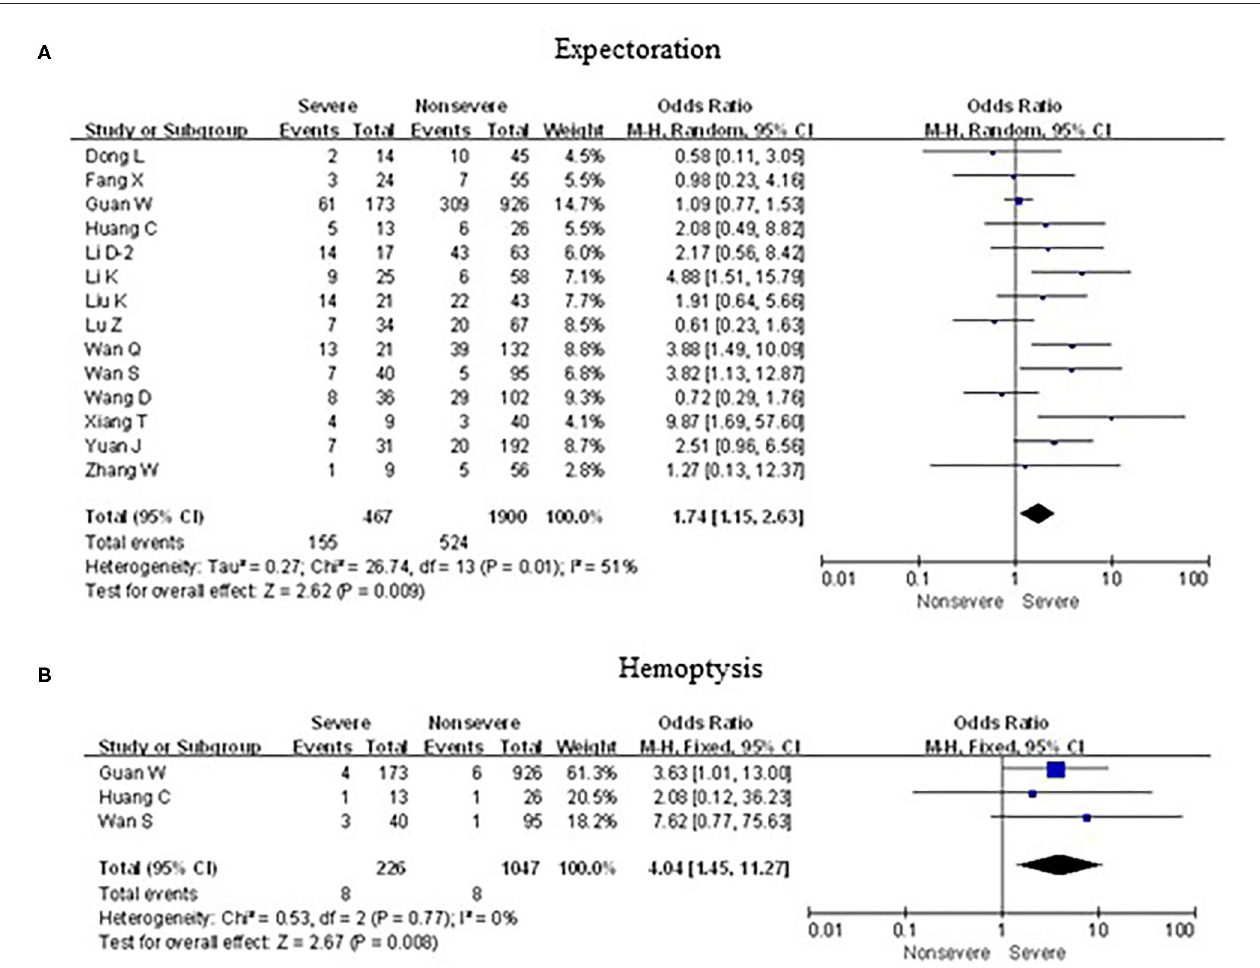
FIGURE 6 | Forest plots of odds ratios (ORs) showed the associations between respiratory symptoms, including expectoration (A) as well as hemoptysis (B) , and disease progression of COVID-19